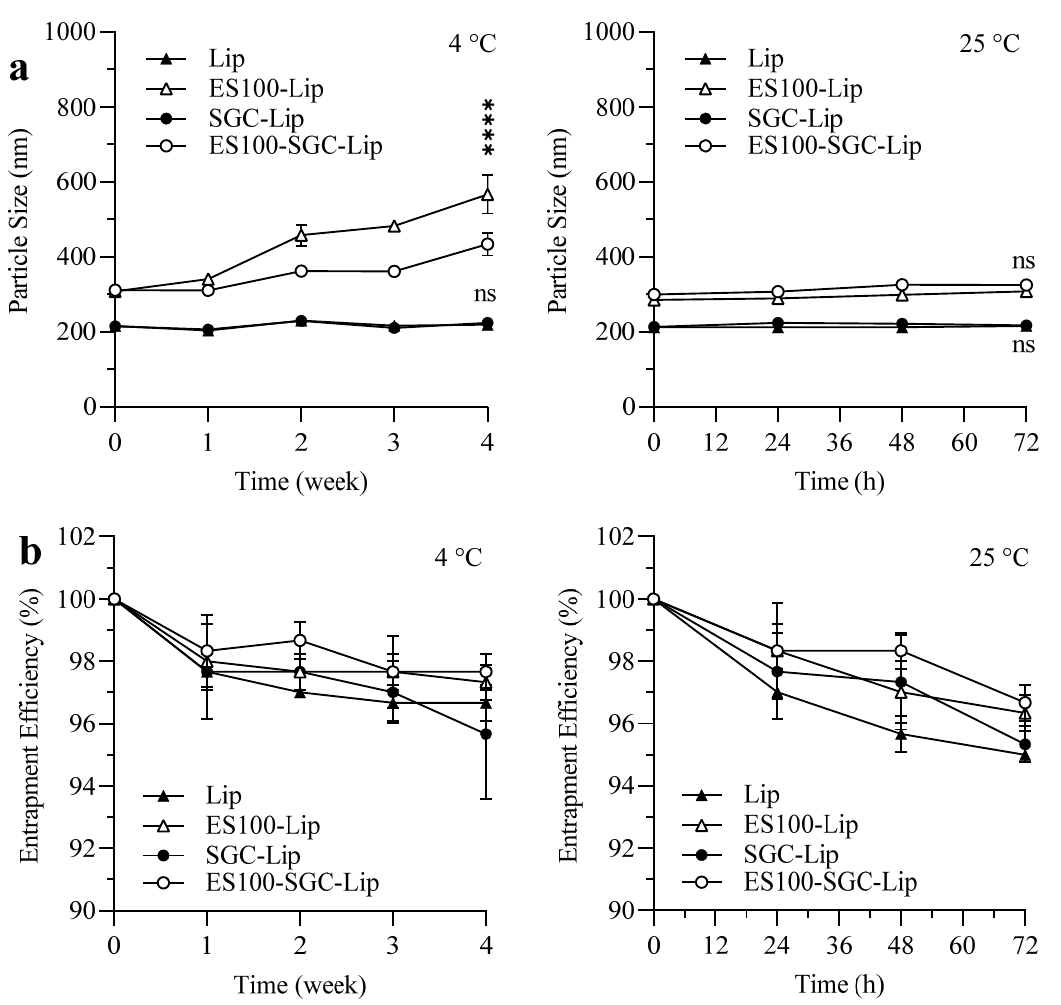
Figure 9. The effect of short- and long-term storage on the ( a ) particle size and ( b ) EE of different liposomal formulations at 25 °C and 4 °C for 72 h and 4 weeks, respectively. Notes: n = 3. (ns p ≥ 0.05, **** p < 0.0001) when SGC-Lip is compared to Lip and ES100-SGC-Lip is compared to ES100-Lip.